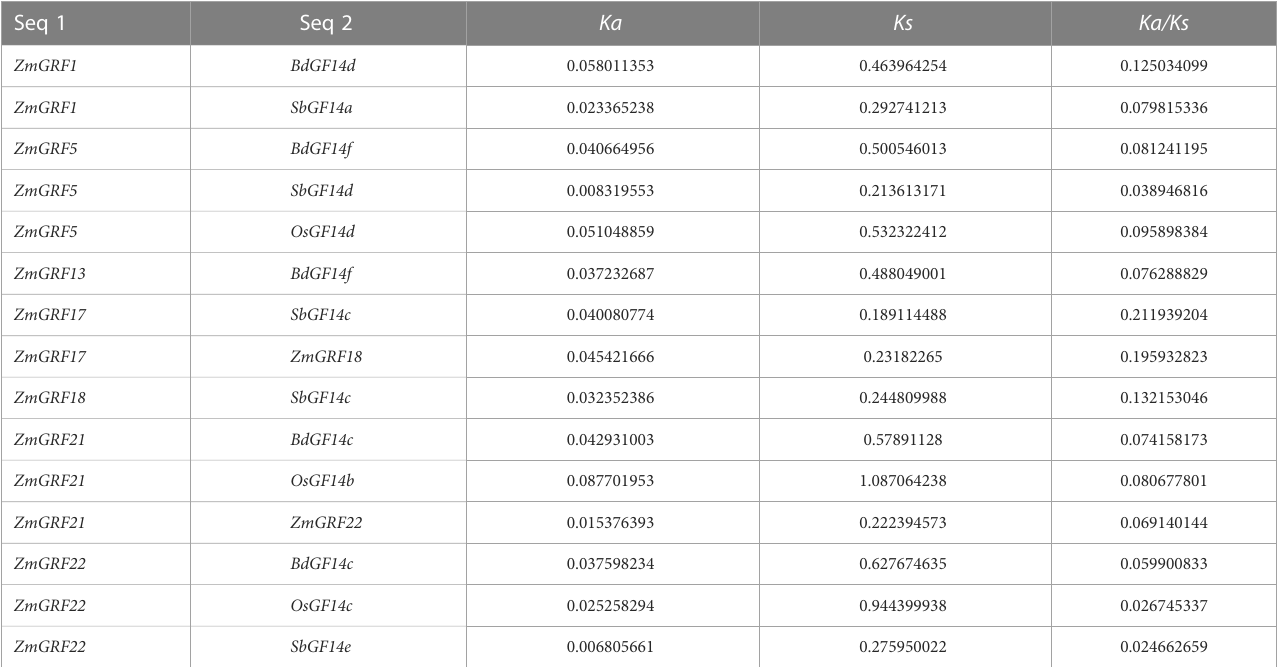
TABLE 2 Evolutionary selection between 14-3-3s in maize and other three plants. Seq